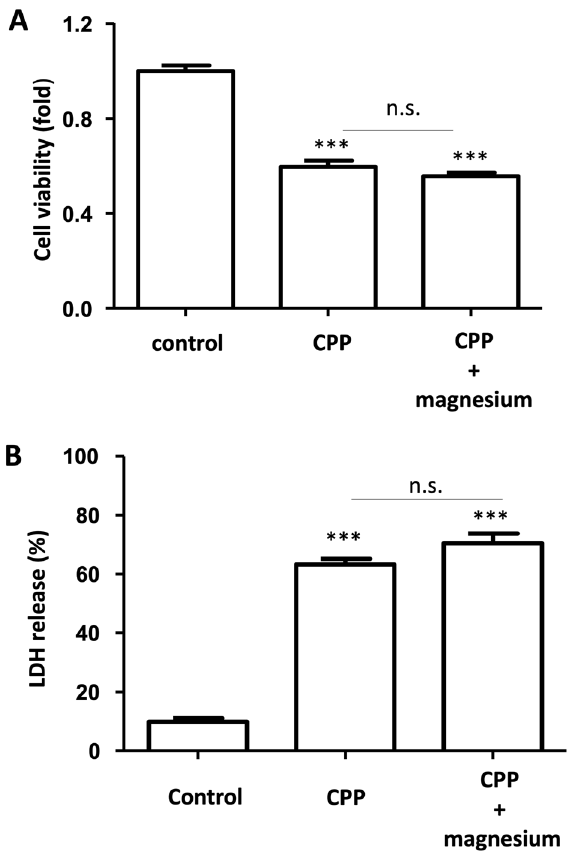
Figure 6. Effects of magnesium on CPP-induced DolKT-1 cell damage. The cell viability was measured by the WST-1 method after 48 h of exposure in the experimental groups ( A ). Data are expressed as the fold change level of the live cells in the control group. n = 8 for each group. LDH release was measured in the control, CPP, and CPP + magnesium groups after 24 h of exposure ( B ). n = 5 for each group. ***P < 0.001 vs.